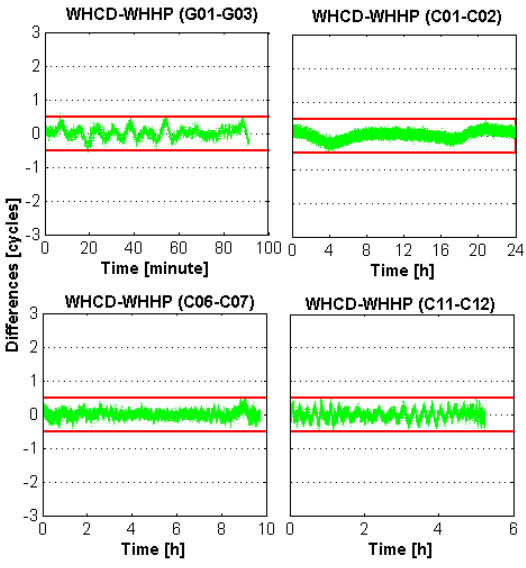
Figure 3. EWL-I time series of the GPS and BDS satellites for baseline WHCD-WHHP. The red line indicates the threshold of rounding. Green dots indicate the values of EWL-I combination. Sensors 2015 , 15 , page–page